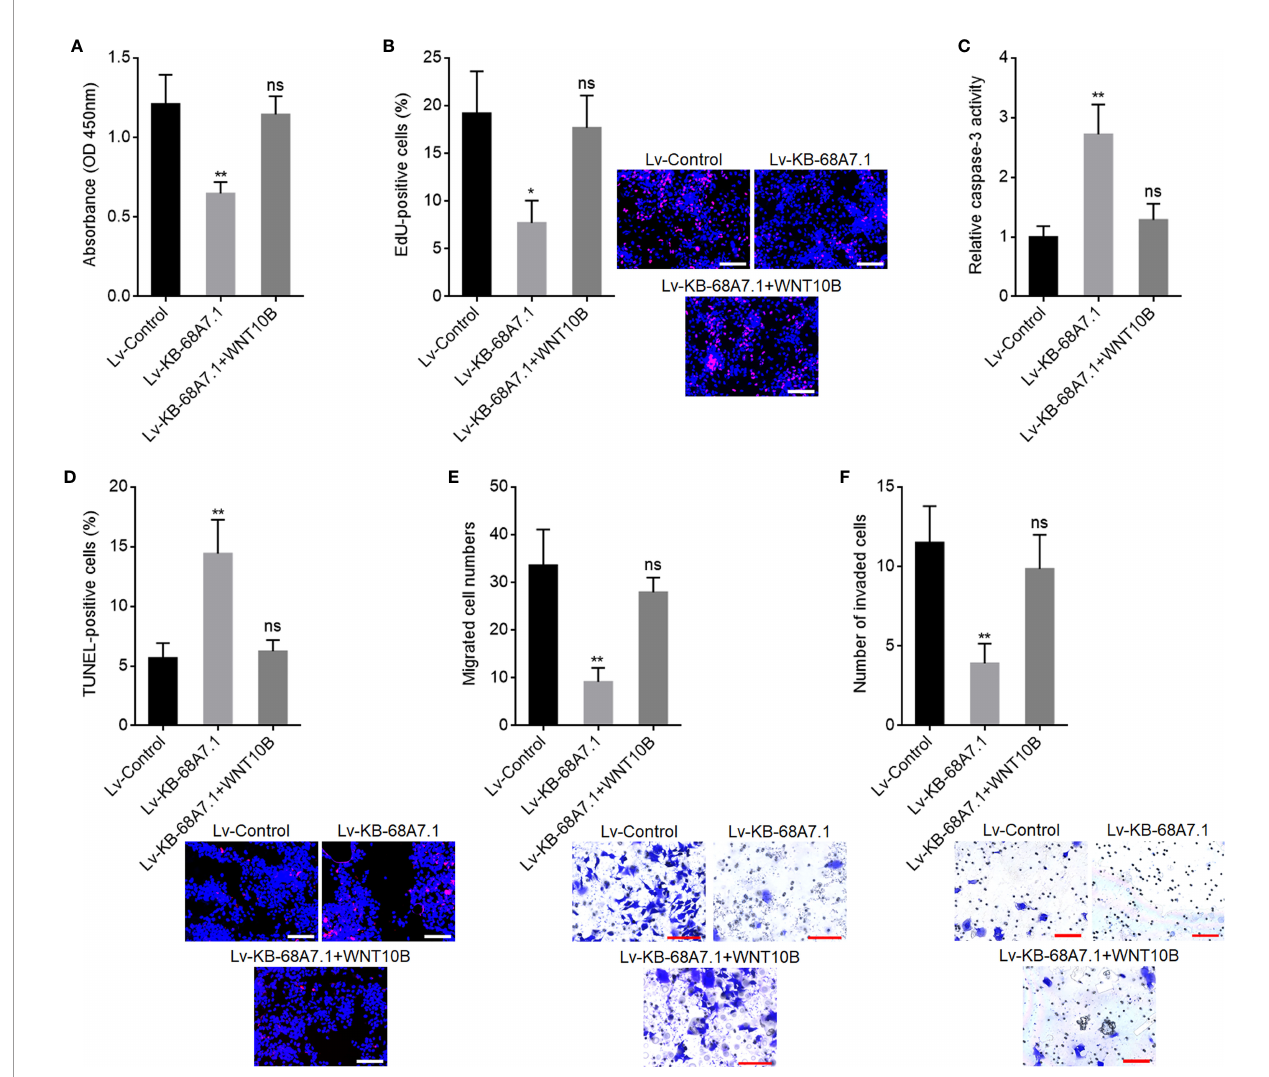
FIGURE 8 | WNT10B reversed the tumour-suppressive roles of KB-68A7.1 in HCC. (A) Cellular proliferation of SNU-398 cells with KB-68A7.1 and WNT10B overexpression or control was measured by CCK-8 assay. (B) Cellular proliferation of SNU-398 cells with KB-68A7.1 and WNT10B overexpression or control was measured by EdU incorporation assay. Red colour indicates EdU-positive and proliferative cells. Scale bars = 100 µm. (C) Cellular apoptosis of SNU-398 cells with KB-68A7.1 and WNT10B overexpression or control was measured by caspase-3 activity assay. (D) Cellular apoptosis of SNU-398 cells with KB-68A7.1 and WNT10B overexpression or control was measured by TUNEL assay. Red colour indicates TUNEL-positive and apoptotic cells. Scale bars = 100 µm. (E) Cellular migration of SNU-398 cells with KB-68A7.1 and WNT10B overexpression or control was measured by Transwell migration assay. Scale bars = 100 µm. (F) Cell invasion of SNU-398 cells with KB-68A7.1 and WNT10B overexpression or control was measured by Transwell invasion assay. Scale bars = 100 µm. Results are shown as mean ± SD based on three independent experiments. *p < 0.05, **p < 0.01, ns, not signi fi cant by one-way ANOVA followed by Dunnett ’ s multiple comparisons